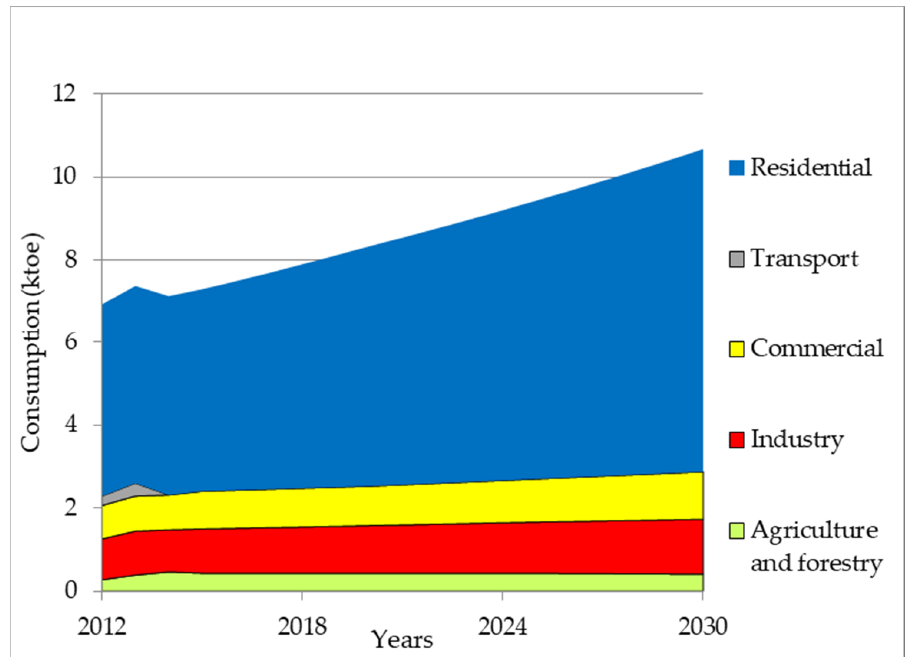
Figure 14. Final energy consumption in Isla de la Juventud for RENES scenario by sector. Source: own elaboration with the model [27].